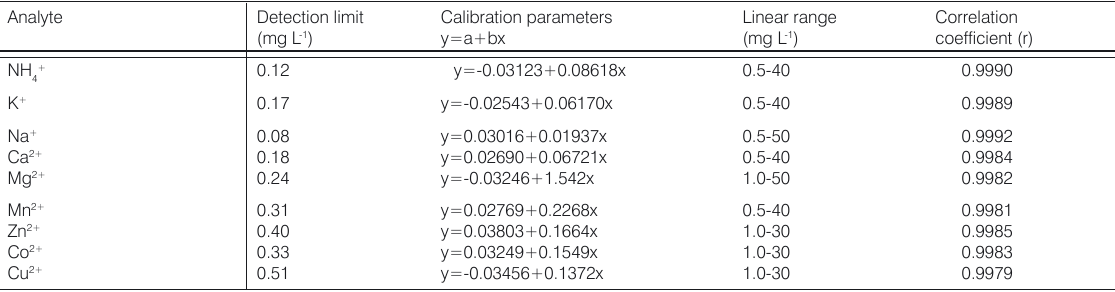
Table 1. Simultaneous determination of 9 inorganic